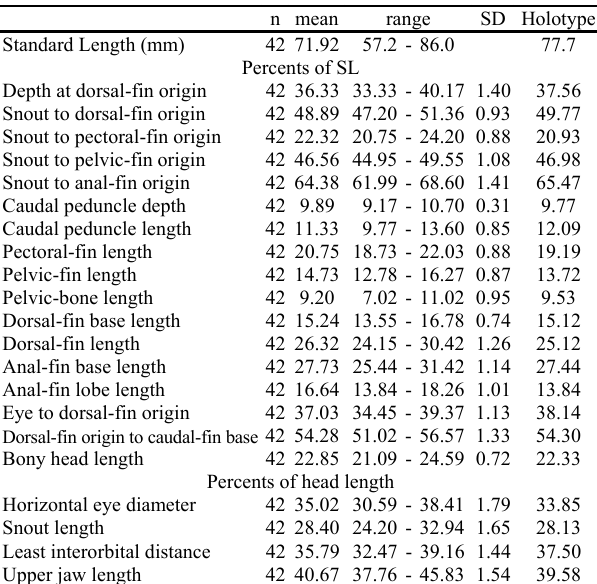
Table 1. Morphometric data for Jupiaba kurua